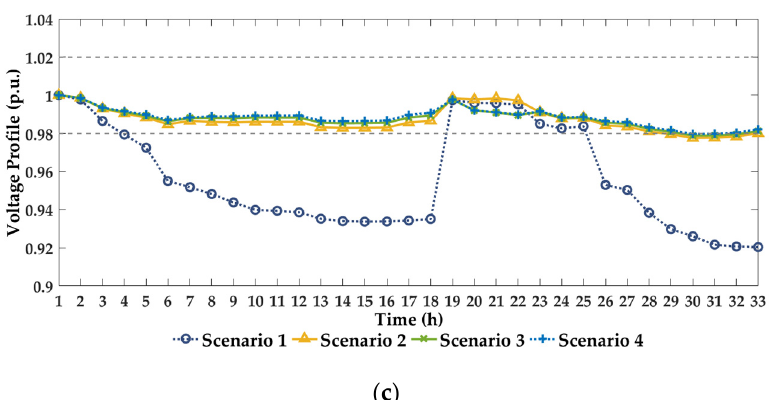
Figure 7. ( a ) Voltage profile of node 18. ( b ) Voltage profile of node 31. ( c ) Voltage profile of the system with four SOPs at 5 pm.